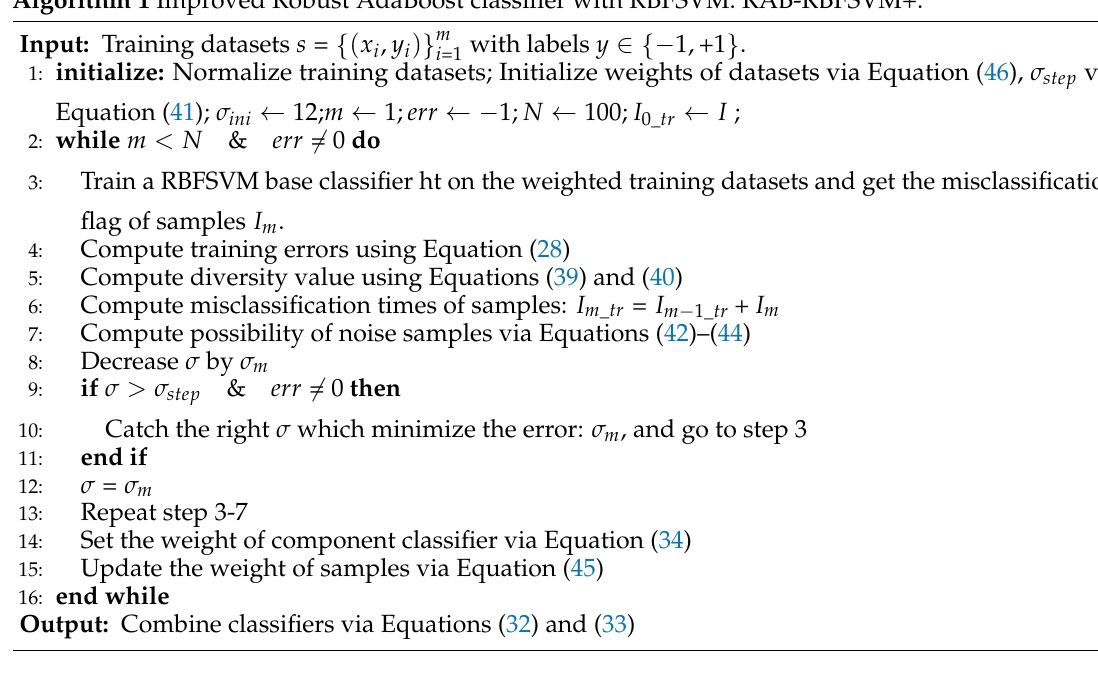
Algorithm 1 Improved Robust AdaBoost classifier with RBFSVM: RAB-RBFSVM+.